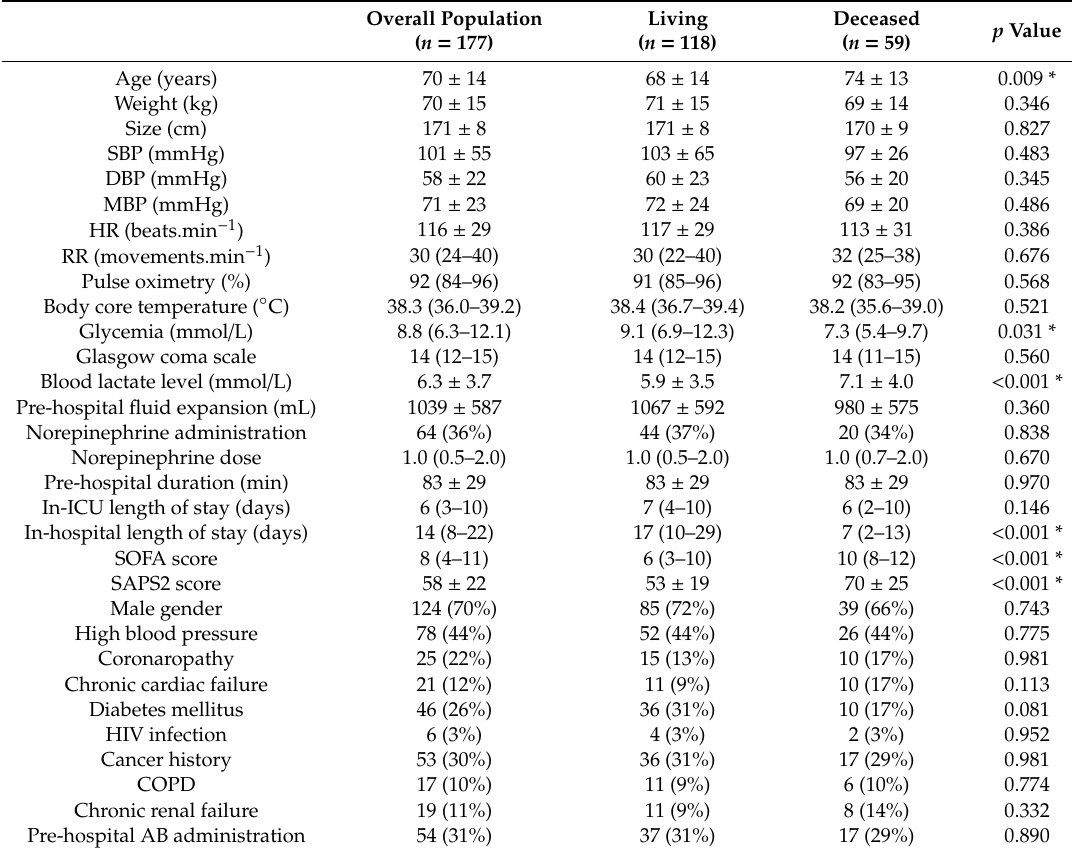
Table 1. Population characteristics.